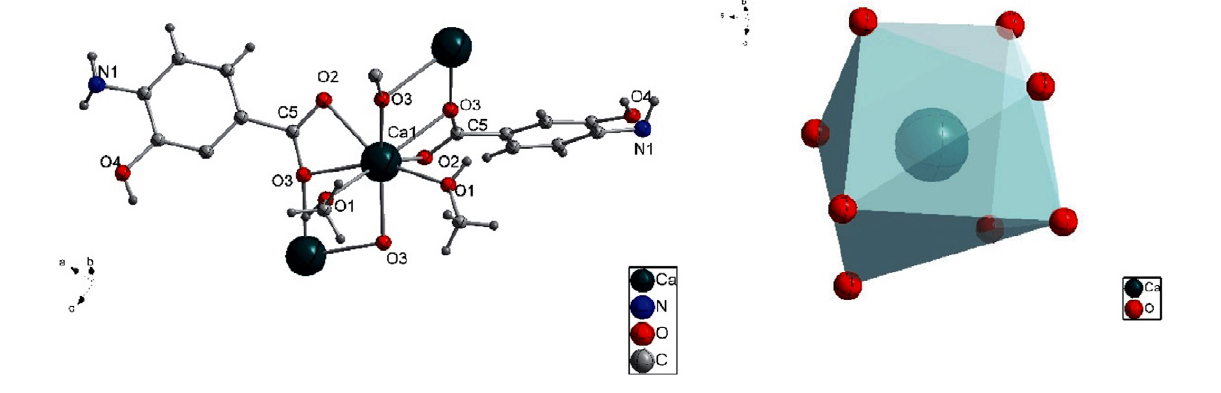
Figure 1. The molecular structure (left) and coordination polyhedron (right) of calcium 4-amino-3-hydroxybenzoate.